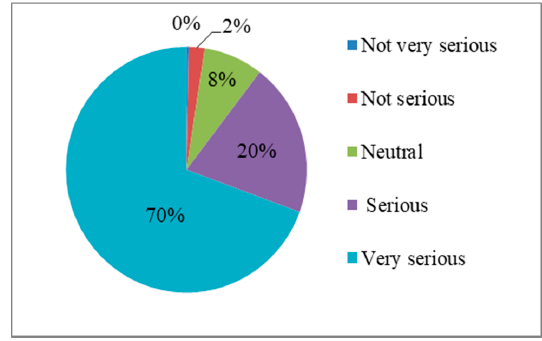
Figure 4. Distribution of disaster experiences frequency.